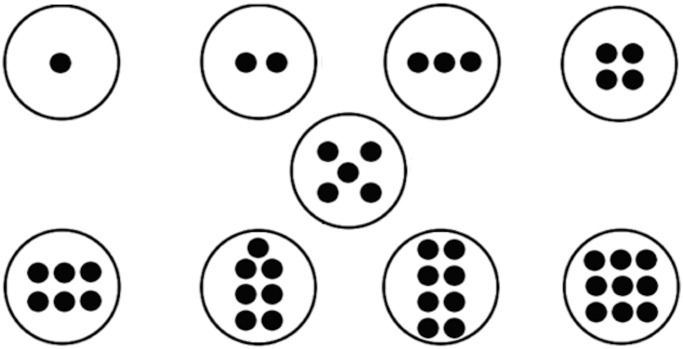
Dot matrix patterns used in Experiment 2.